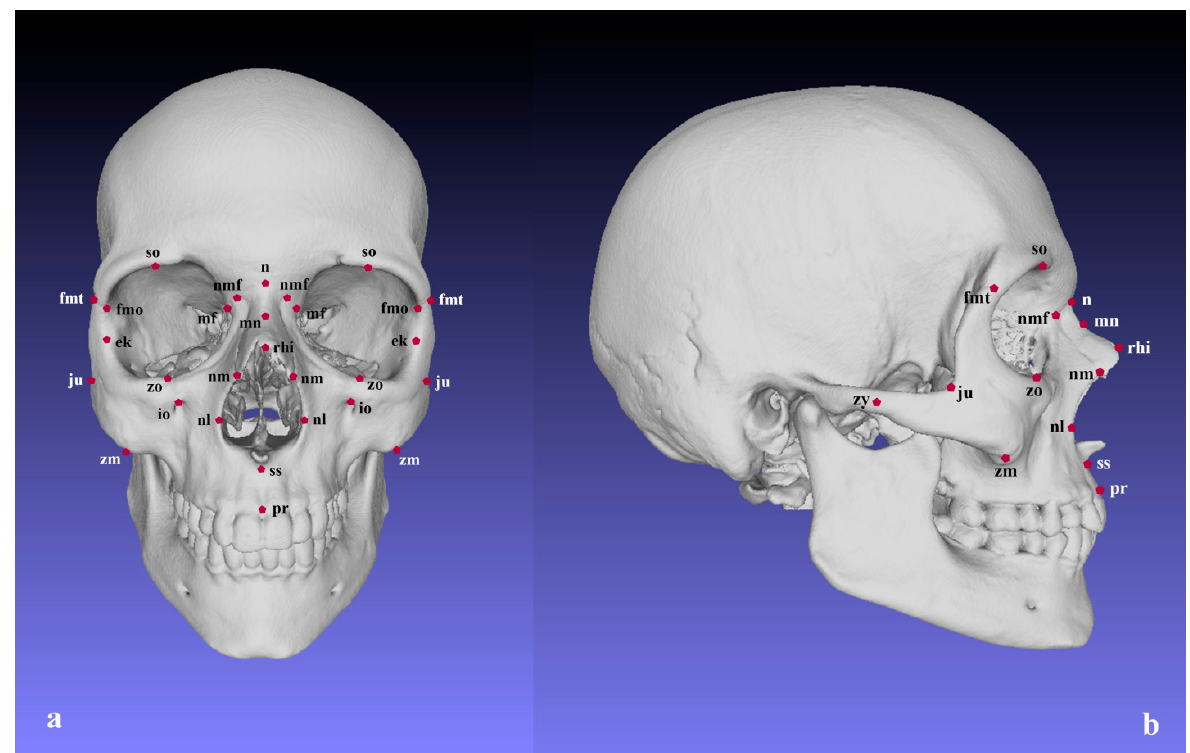
Figure 1. Landmarks of the viscerocranium: ( a ) frontal view; ( b ) lateral view. Based on the digitized landmarks, five configurations were arranged: viscerocranium, orbital region, nasal region, maxillary region, and zygomatic region. The landmark data in each configuration were processed using GM techniques. Data for shape (Procrustes coordinates) and size (centroid size, CS) were calculated for each configuration. A